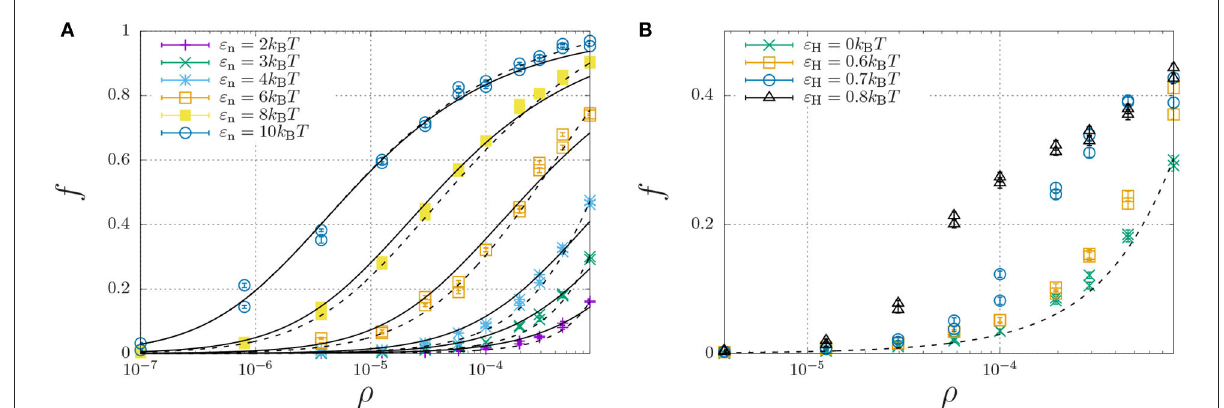
FIGURE4 Fraction of dimerised A β , f , plotted against the number density, ρ (in units of the lattice spacing). Well below the overlap concentration of ρ 10 − 4 (corresponds roughly to 100 mg/ml, refer to main text) the solution can be considered dilute, while at higher concentrations excluded = volume interactions become important. (A) The dimerisation energy ε n is varied from 2 to 10 k B T without hydrophobic interactions ( ε H 0). The = K n,0 exp( ε n ) with a non-constant K n,0 (Table 1), while the solid curves are individual fits using Equation (12) with a dimerisation constant K n = K n,00 exp[( ∂ [ 1 S n / k B ] /∂ρ ) ρ ] with constant K 00 dashed curves represent a simultaneous fit of all data using K n,0 6.85 and an entropic = = excluded-volume correction ( ∂ [ 1 S n / k B ] /∂ρ ) 1.3 10 3 . (B) The dimerisation energy is fixed ε n 3 k B T , while the hydrophobicity is increased = · = from 0 up to ε H 0.8. The dashed and dotted curve are calculated using K n 6.85exp(3 1300 ρ ) and K n 6.85exp(3.6 1300 ρ ), respectively. = = + = + The data for ε H 0.7 and 0.8 are underestimates, as ongoing LLPS enables the slow increase of aggregate sizes. =